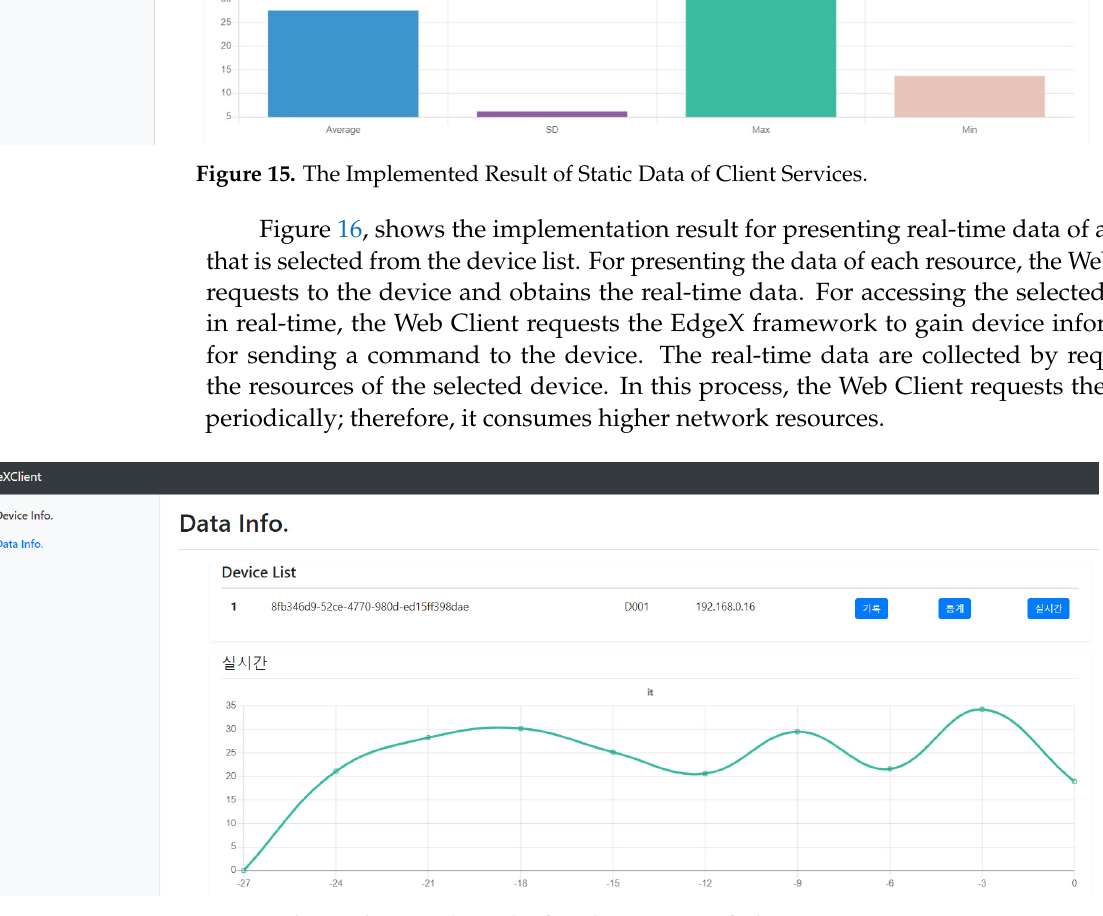
Figure 16. The Implemented Result of Real-Time Data of Client